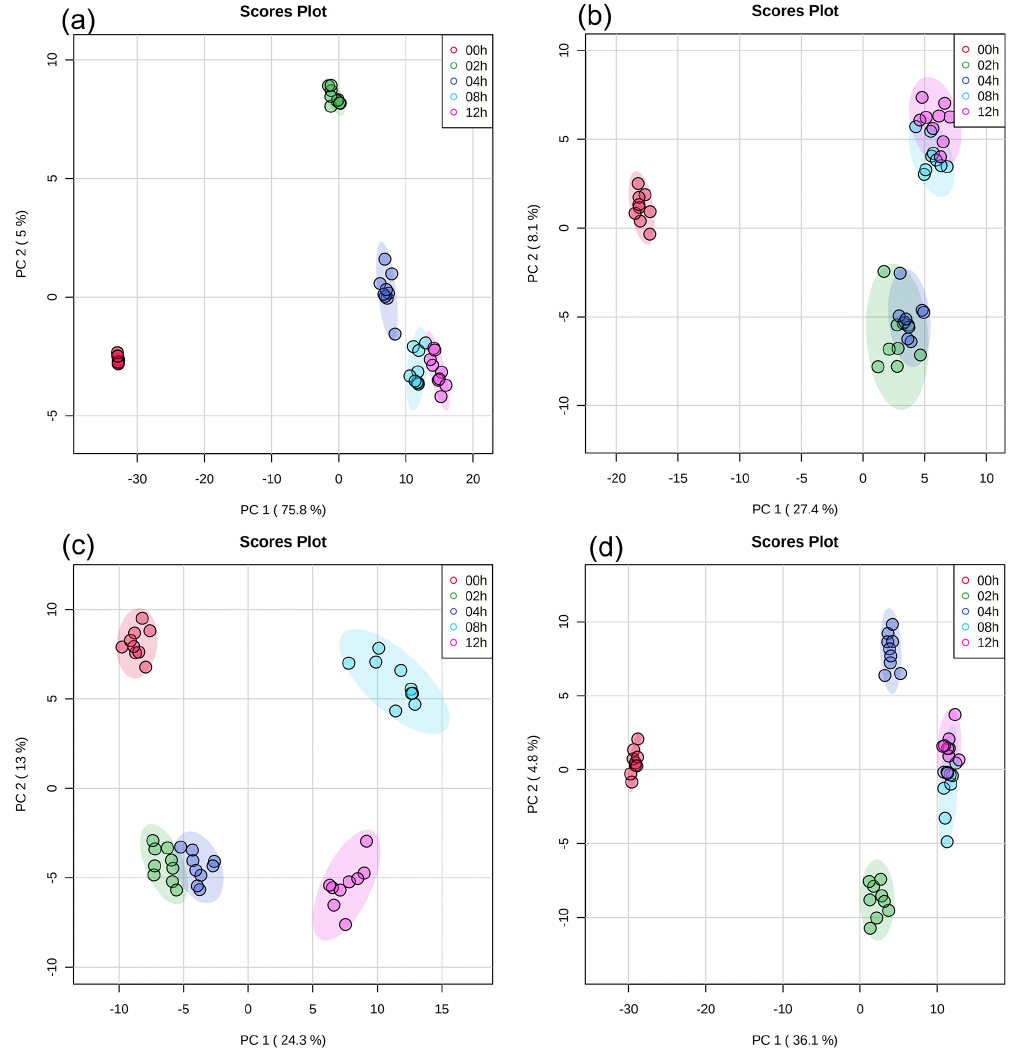
Figure 2. PCA results of UPLC-MS data with (a) water-soluble compounds and (b) water-insoluble compounds from E. hormaechei B0910 and (c) water-soluble compounds and (d) water-insoluble compounds from E. hormaechei pf0910 during exposure to light at pH4.3. Each cluster representing a different light exposure time (i.e., 0, 2, 4, 8, and 12h) has nine points, since three samples were taken at each light exposure time, and UPLC-MS analysis was performed in triplicate for each